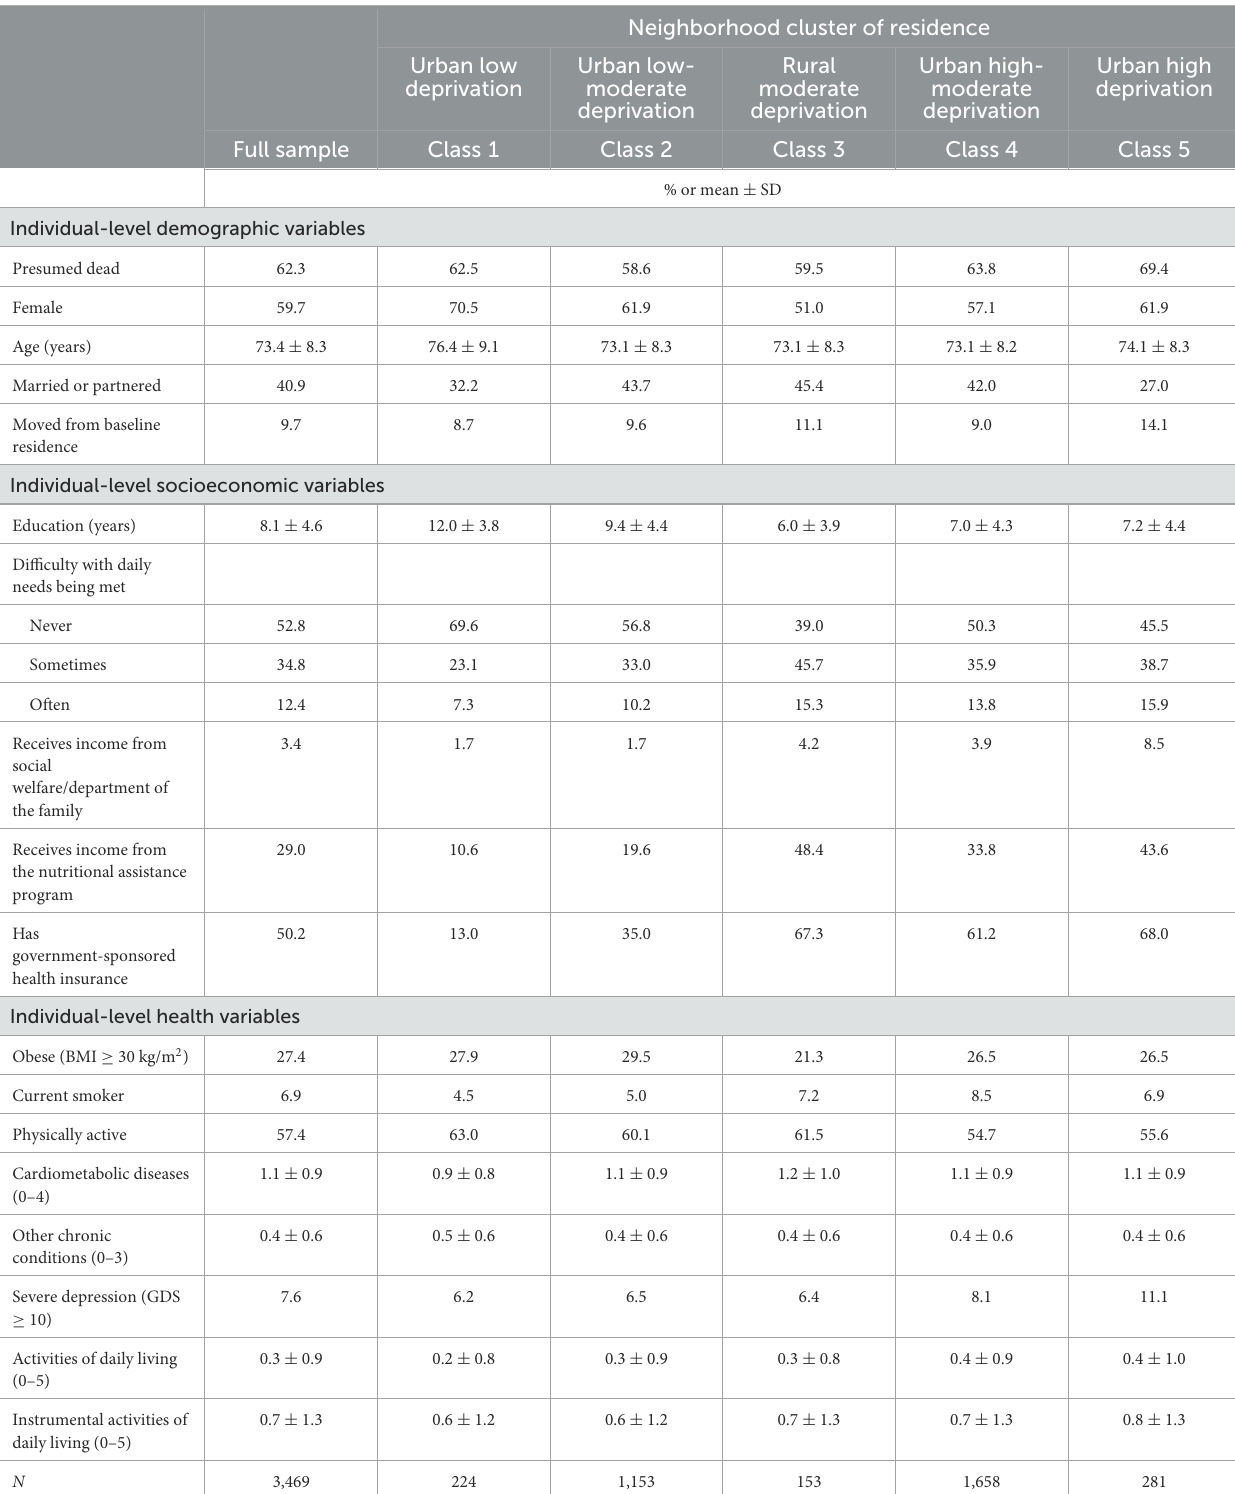
TABLE 2 Characteristics of observations included in multilevel analysis by neighborhood cluster, PREHCO